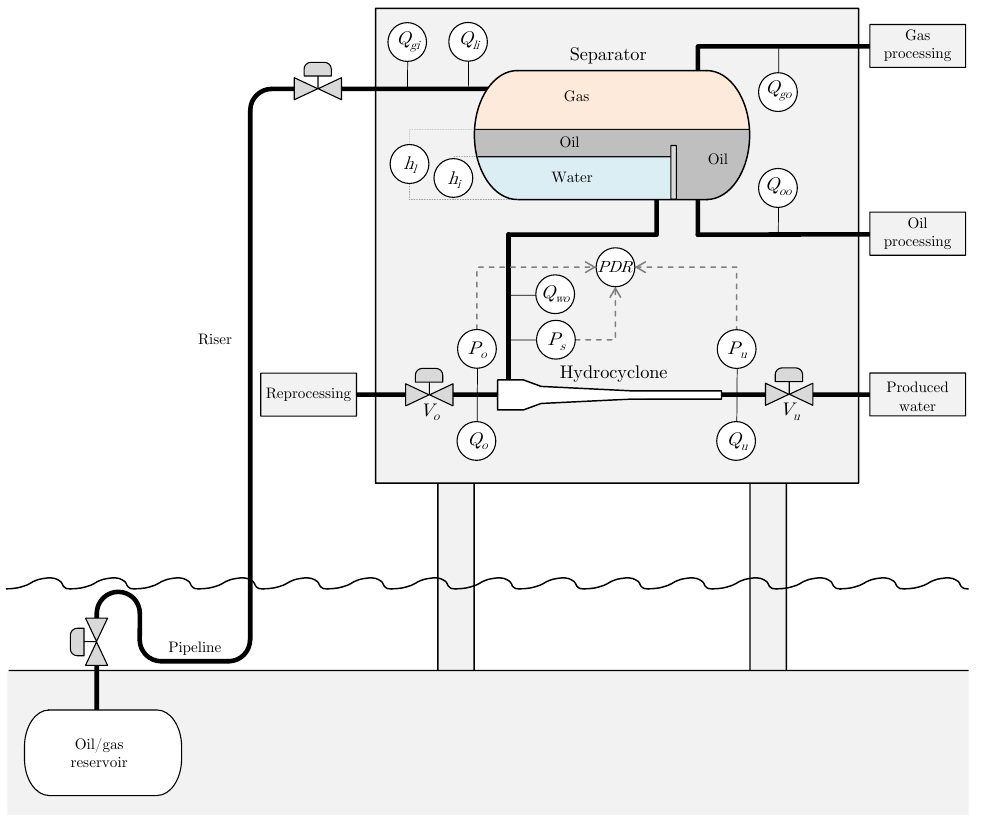
Figure 1. Overview of the offshore oil and gas production and produced water treatment